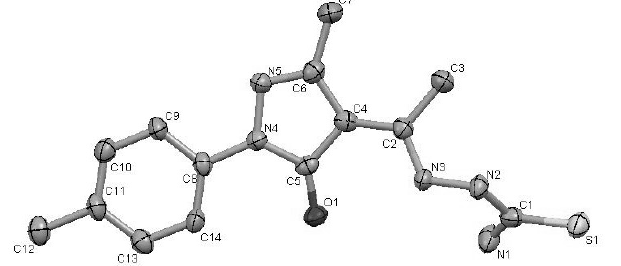
Figure 4. Molecular structure of compound